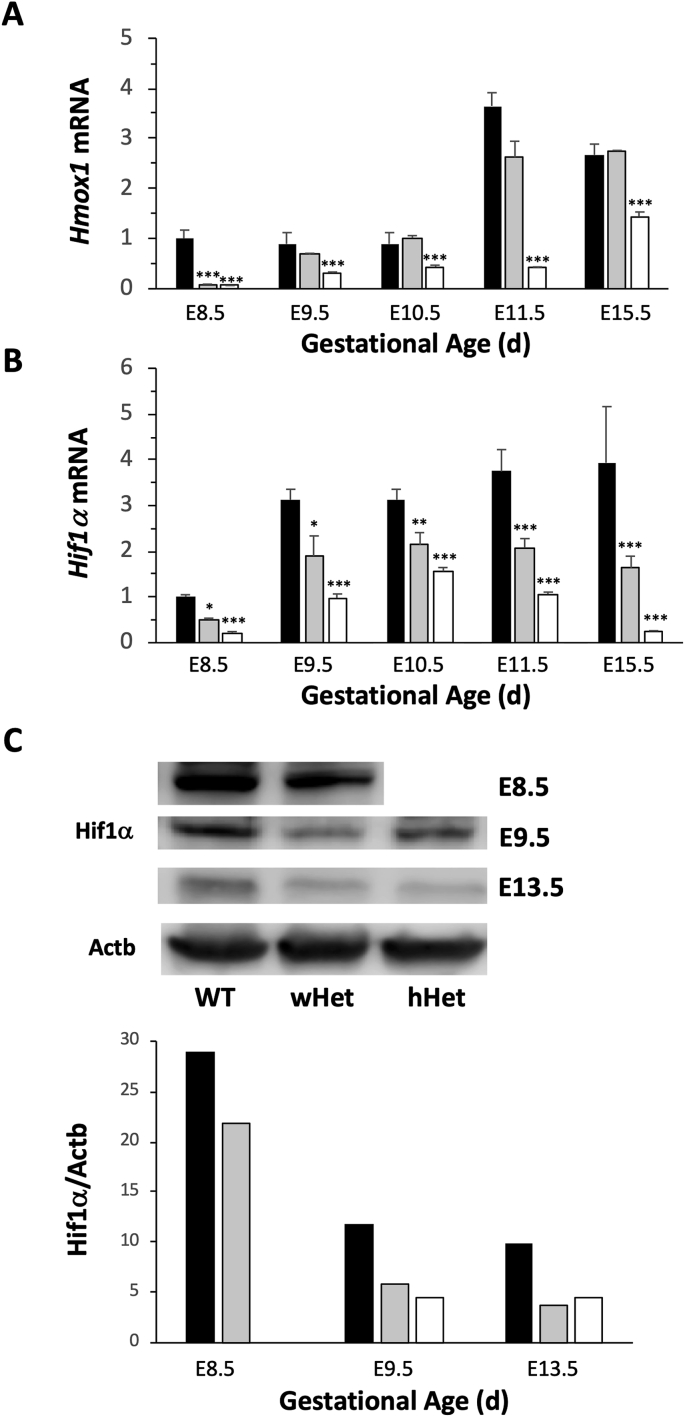
Het placentas have significantly reduced Hif1α expression. (A) Hmox1 deficiency in placentas from Het pregnancies with WT fetuses (wHet, gray bars, n = 3 at each age) or Het fetuses (hHet, white bars, n = 3 at each age) was confirmed by measuring mRNA levels using real-time RT-PCR, normalized to Gapdh and Actb levels, and compared with those fetuses from WT pregnancies (WT, black bars, n = 3 at each age). (B) Hif1α mRNA expression was measured in placentas at various gestational ages harvested from WT pregnancies (WT, black bars, n = 3 at each age), Het pregnancies with WT fetuses (wHet, gray bars, n = 3 at each age) or Het fetuses (hHet, white bars, n = 3 at each age). Hif1α expression was normalized to Gapdh and Actb levels. (C) Hif1α protein levels in placentas at various gestational ages harvested from Het pregnancies with WT fetuses (wHet, gray bars) or Het fetuses (hHet, white bars) compared with placentas from WT pregnancies (black bars) are shown by Western blots. Hif1α expression was normalized to Actb levels. Due to the extremely small size of fetuses at E8.5, standard genotyping could not be performed. Therefore, Hmox1 mRNA levels were used to differentiate wHet and hHet placentas for mRNA studies, but was not feasible for Western blots. *P < 0.05; **P < 0.01; ***P < 0.005.